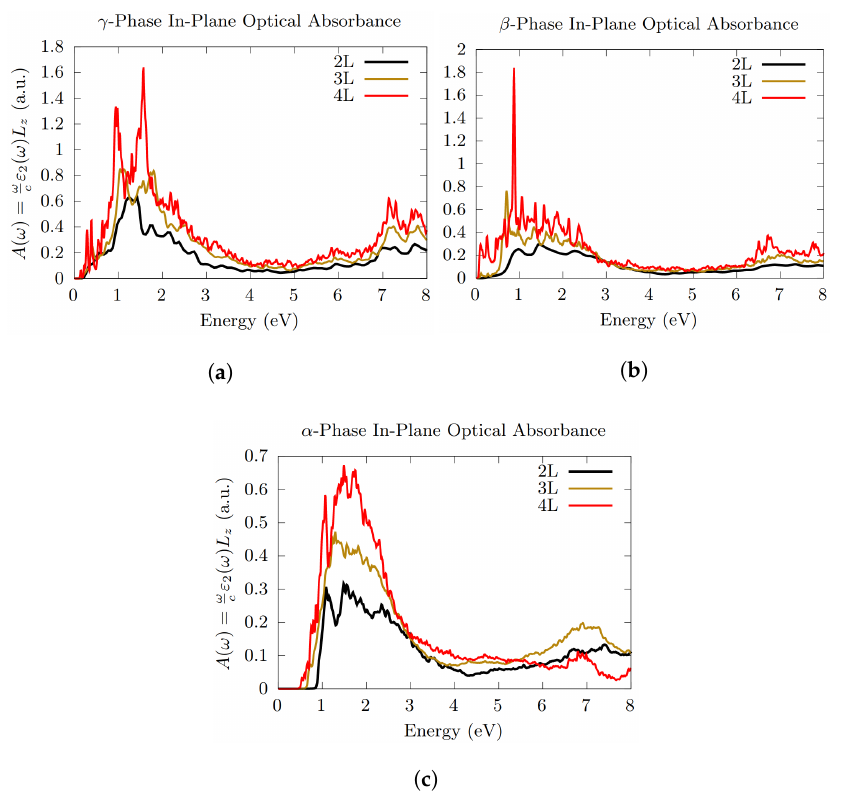
Figure 8. In-plane optical absorbance comparison between 2L, 3L and 4L γ - ( a ), β - ( b ) and α -Te ( c ), with the inclusion of SOC. Overall, the absorption energy threshold decreases for increasing number of layers (see Table